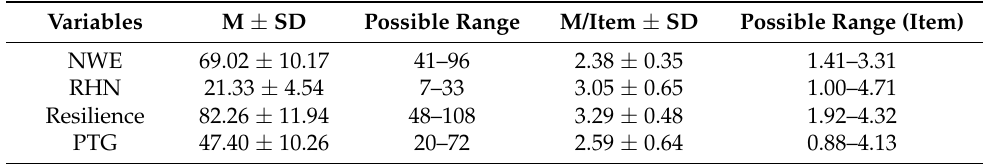
Table 2. Degrees of the nursing work environment, relationship with the head nurse, resilience, and posttraumatic growth. ( n =